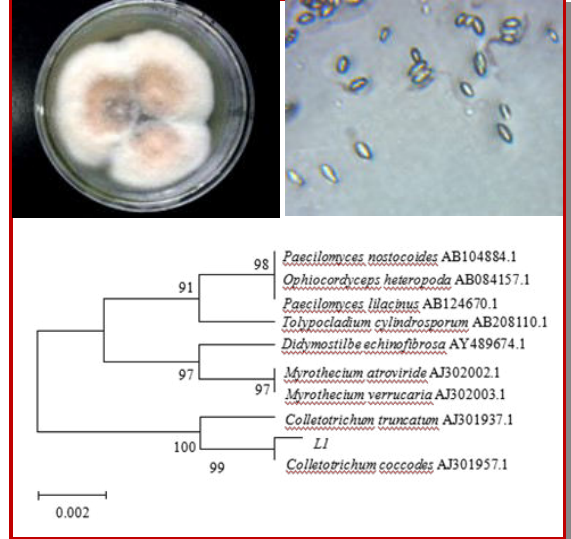
Figure 2: Morphological characteristics and phylogenetic tree of strain L1